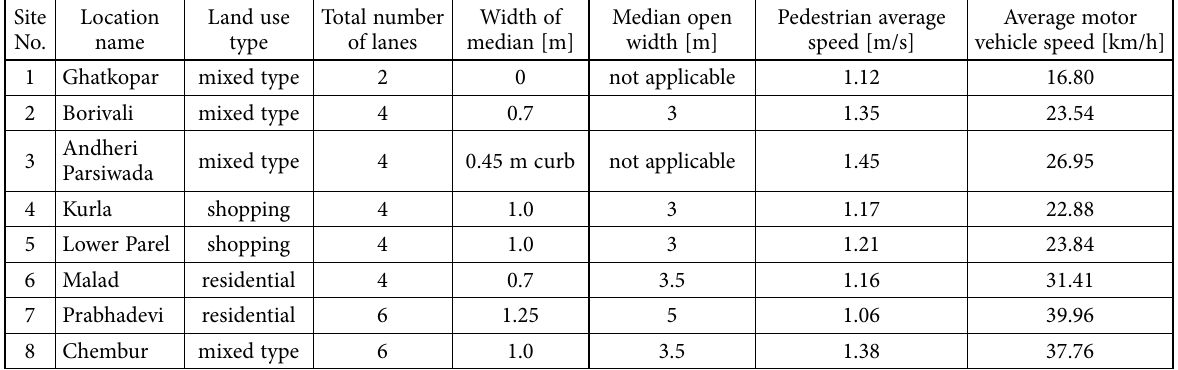
Table 1. The roadway and operational characteristics of the selected crosswalks Site